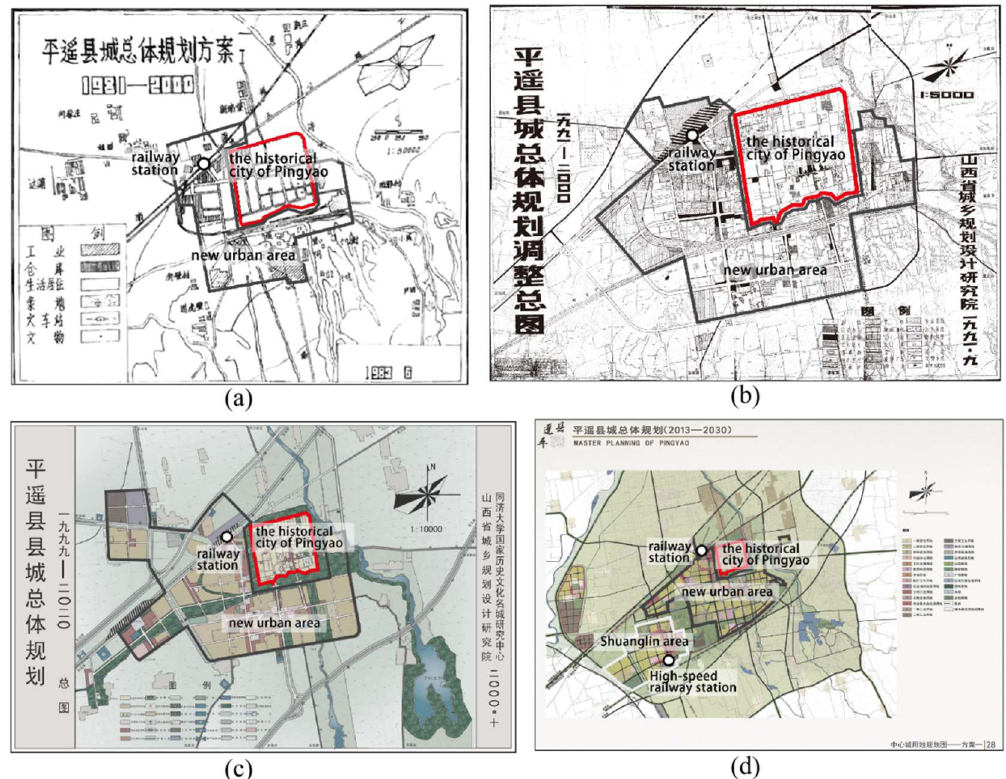
Figure 9. Master plan of Pingyao in years 1981–2000 ( a ), 1991–2000 ( b ), 1999–2020 ( c ), 2013–2030 ( d ). (Maps provided by Department of Housing and Urban-Rural Development of Shanxi Province).